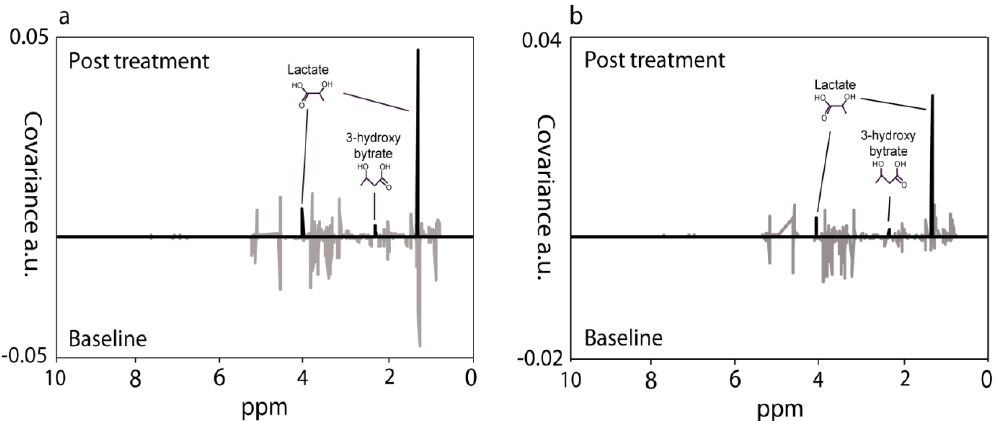
Figure 3. Metabolite identification based on limit discriminant weight plots. Limit discriminant weight plots of back-scaled OPLS-DA data from GDL milk and probiotic milk treated patient groups with variable covariances presented with different R 2 cut-off values. ( a ) GDL acidified milk group; ( b ) Probiotic milk group. Peak at δ 1.32 ppm represents the β of lactate and the peak at δ 4.10 ppm represents the α of lactate. The CH3 CH peak at δ 2.34 ppm represents the α proton of 3-hydroxybutyrate. Grey spectra show all CH2 covariances and black spectra have a cut-off value R 2 >